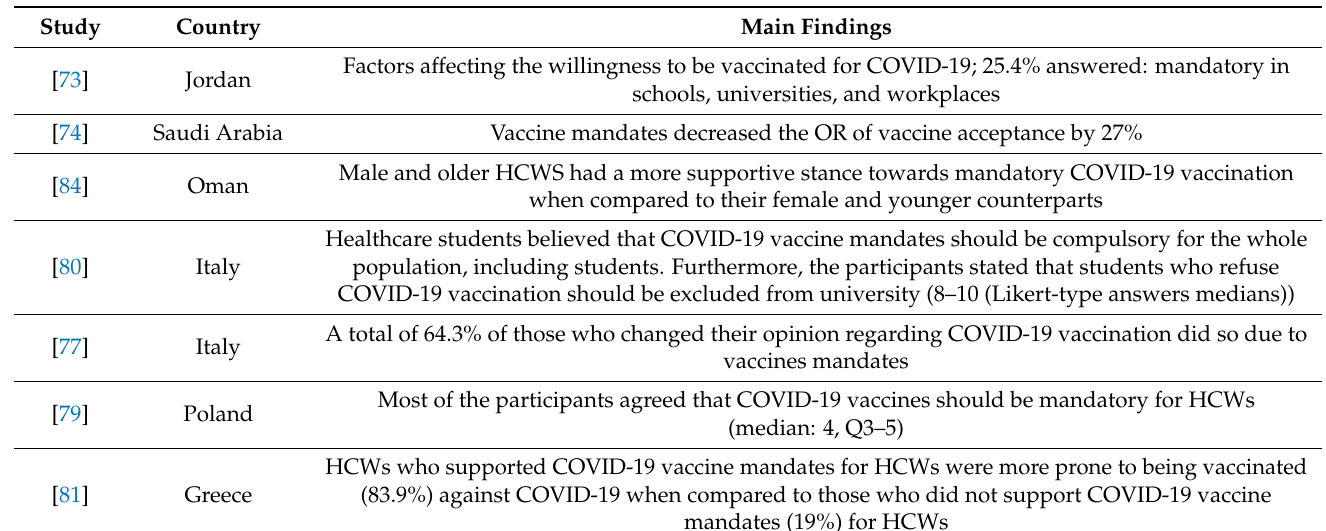
Table 6. Main findings of the studies not included in quantitative synthesis of